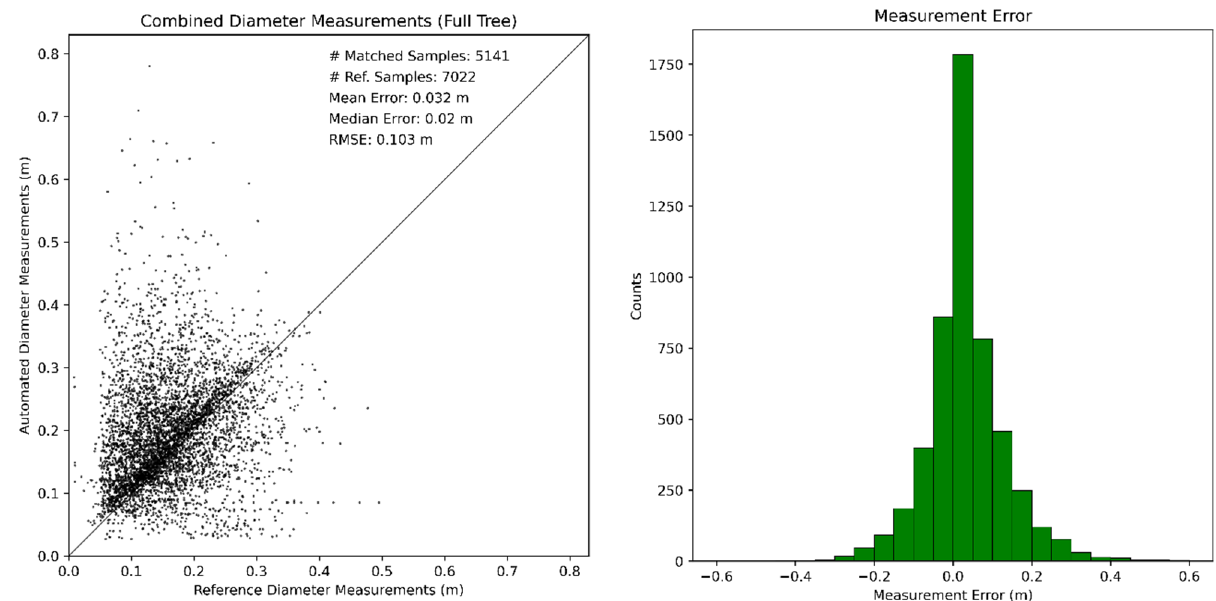
Figure 13. Left shows a scatter plot of reference diameters against the remotely sensed and automatically extracted diameter measurements. This does not include the measurements which were not successfully matched between reference and automatic datasets. Right provides a histogram to visualise the distribution of the measurement errors.